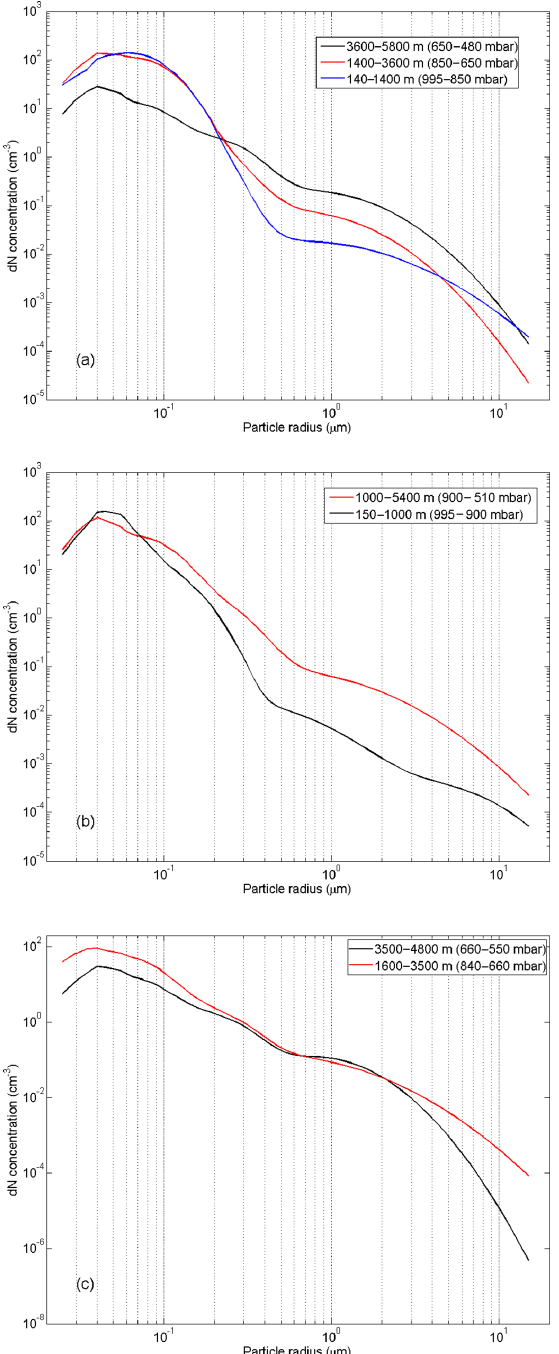
Figure 4. Measured dimensional distributions of dust aerosol by the instruments on board the ATR-42 at different altitudes: (a) 22 June, (b) 28 June, and (c) 3 July 2013. In the first case, there are three distinct dust layers, instead of two. The extra layer (blue curve) is that closest to the surface: on that day, dust aerosol is more abundant than in the other two